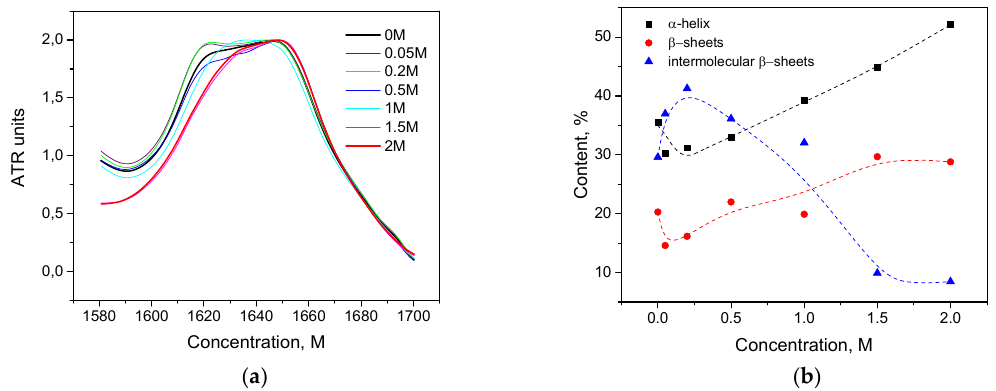
Figure 15. Changes in the character of the Amide I band ( a ) and conformational transition ( b ) of HSA in 10% wt. aqueous solution at 80 °C in the interaction with various concentrations of KCl.